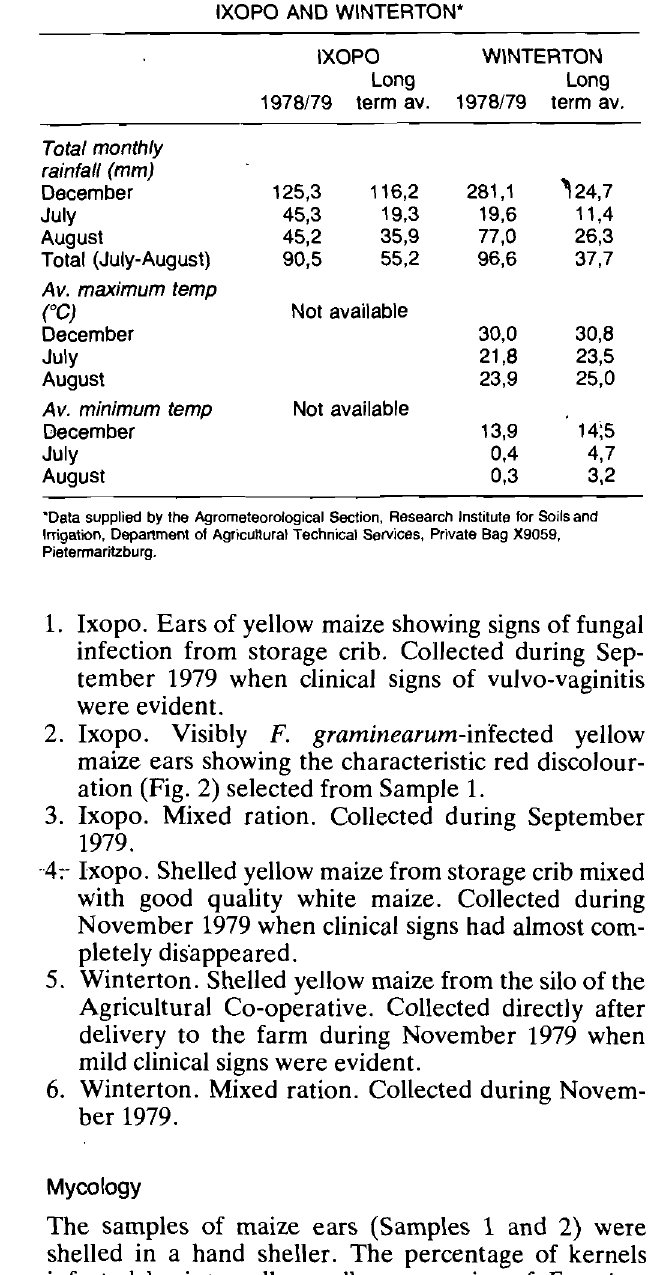
Table 2: INCIDENCE OF FUSARIUM SPECIES IN MAIZE ASSOCIATED WITH PORCINE HYPEROESTROGENISM